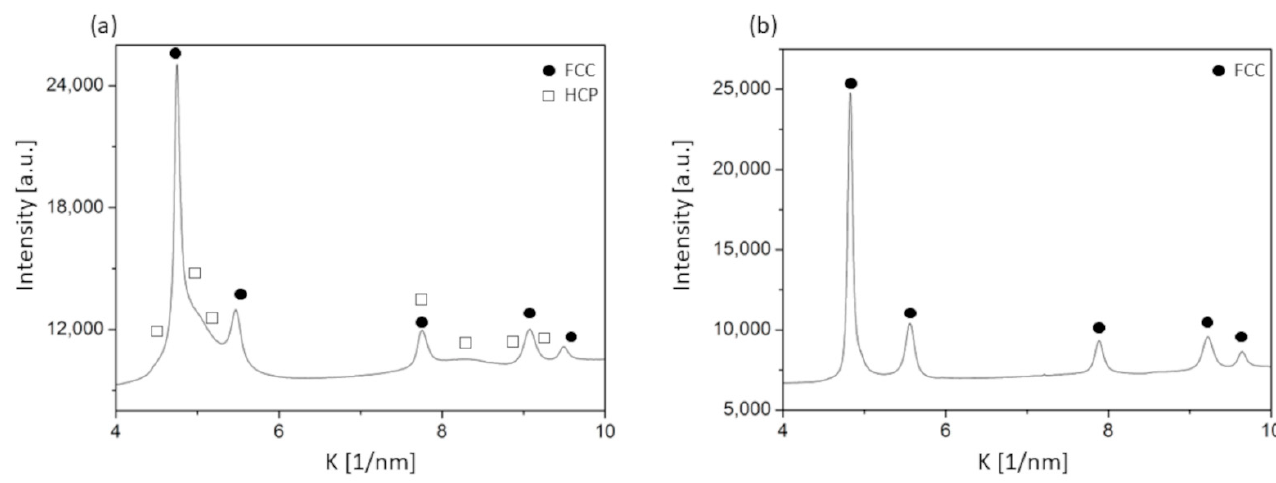
Figure 2. Illustrative examples for the XRD patterns taken on selected points in the ( a ) FCC+(HCP) and ( b ) FCC regions of the Co-Cr-Fe-Ni CCA film.